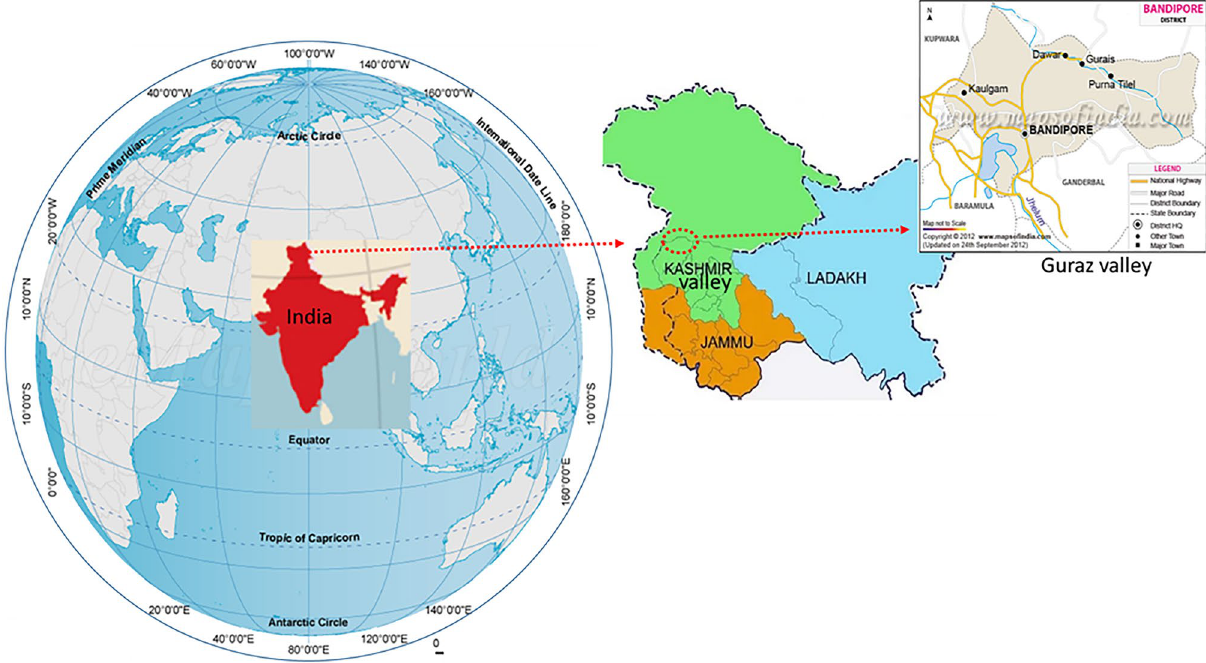
Figure 10. Study area map of Guraz valley in Kashmir region-India (Microsoft power point 2013; https:// world mapbl ank. org/ wordp ress/ wp- conte nt/ uploa ds/ 2021/ 08/ Locat ion- of- India- on- the- World- map.